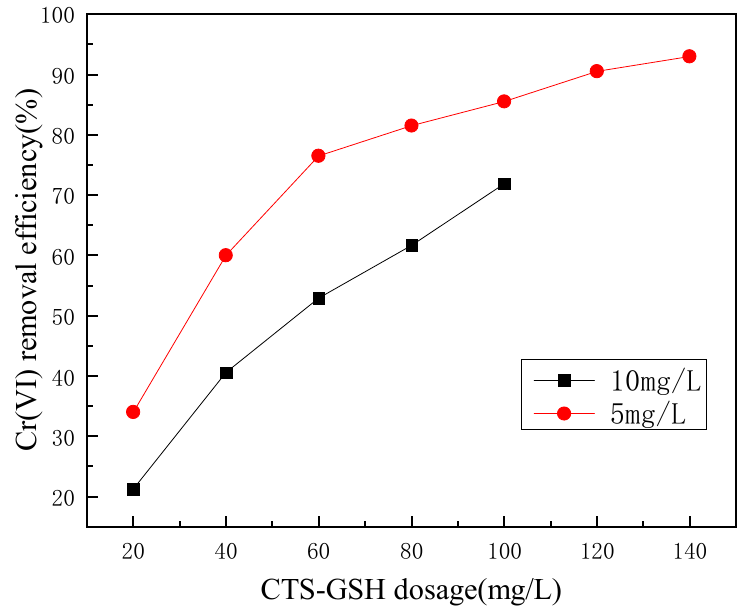
Figure 6. Effect of CTS-GSH dosage on Cr(VI) removal.